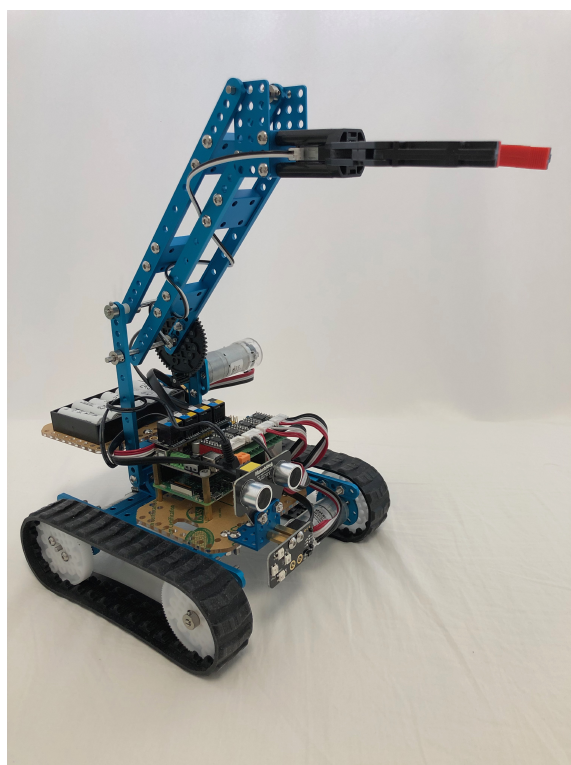
Figure 15. Laboratory mechatronic device Makeblock Robotic Arm